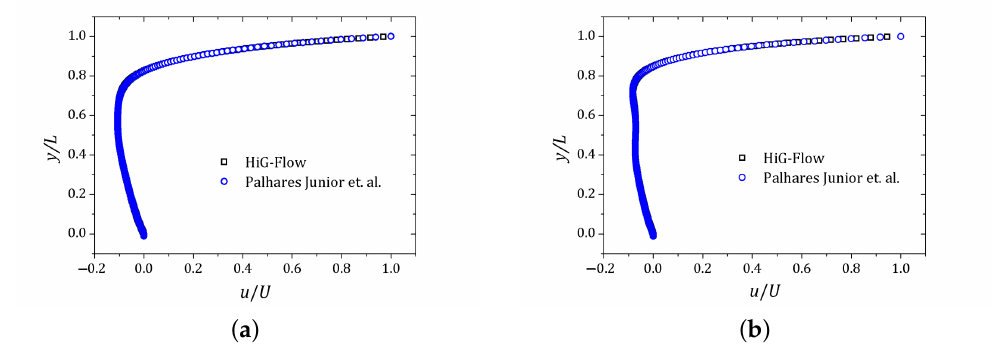
Figure 6. Velocity field u obtained along the vertical line x = 0.5: ( a ) De = 1.0; ( b ) De =